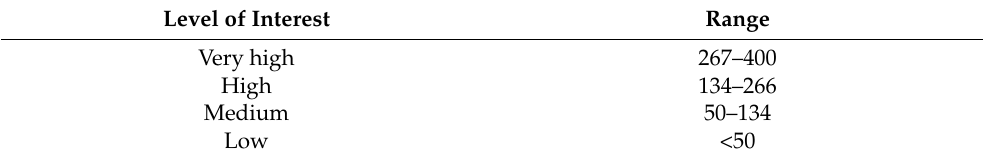
Table 2. Classification of the level of interest according to the weights